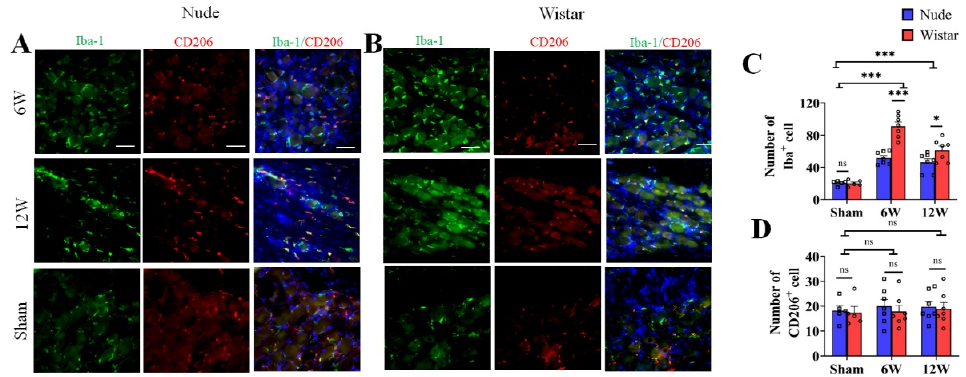
Figure 2. The number of activated (Iba1+) and M2 macrophages (CD206+) in the DRG. ( A , B ) Immunofluorescence staining of activated macrophages (Iba1, green) and M2 (CD206, red) in DRG tissue in sham, 6-week, and 12-week groups ( A , B ). Following nerve injury, both groups exhibited more activated macrophages than sham rats in DRG tissue; however, M2 macrophages (CD206) exhibited similar expression among all groups. ( C , D ). Quantitative analysis associated with the percentage of activated macrophages ( C ) and M2 ( D ). The number of activated macrophages in the DRG of Wistar rats was more than that in nude rats at 6 or 12 weeks. The number of M2 macrophages exhibited no difference. Scale bar 50 μ m. Two-way ANOVA with Bonferroni’s post-test was applied. Sample size: n = 7 at 6 or 12 weeks and n = 5 in sham groups (Wistar and nude rats) * p < 0.05, *** p < 0.001; nude rats vs. Wistar rats, or sham vs. 6 W or 12 W.